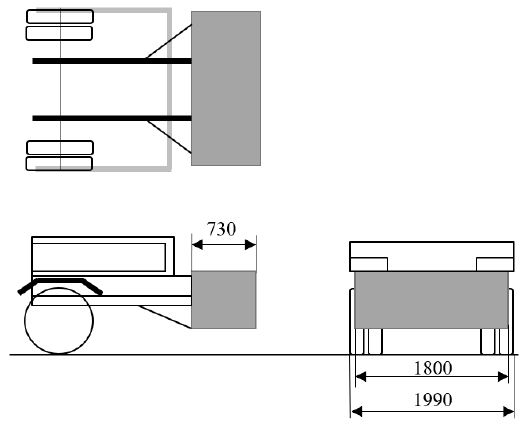
Figure 12. Impact energy absorbing device mounted behind the vehicle.